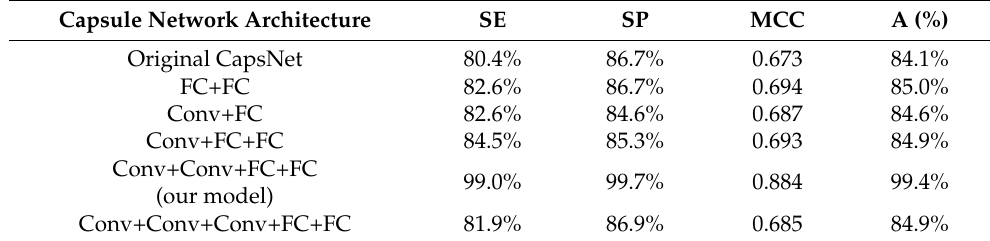
Table 3. Comparing results with a different architecture.